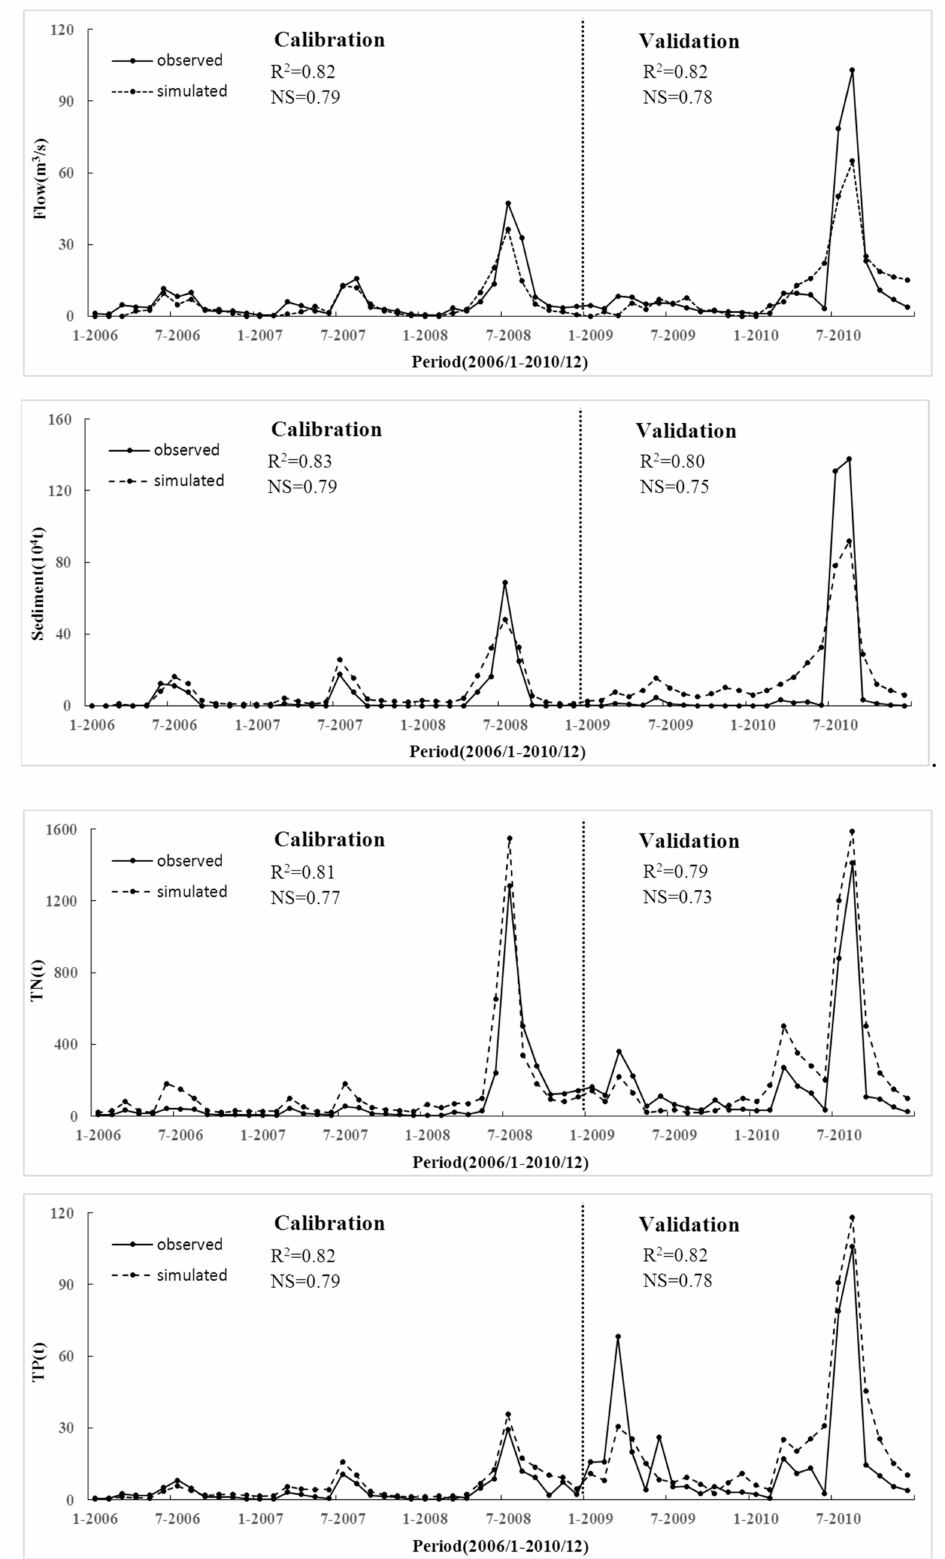
Figure 3. Flows, sediments, TN and TP loads curves for the calibration and validation